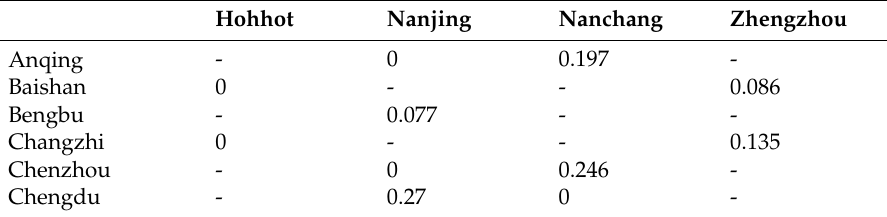
Table 3. The weight of synthetic control group corresponding to each treatment group. Hohhot Nanjing